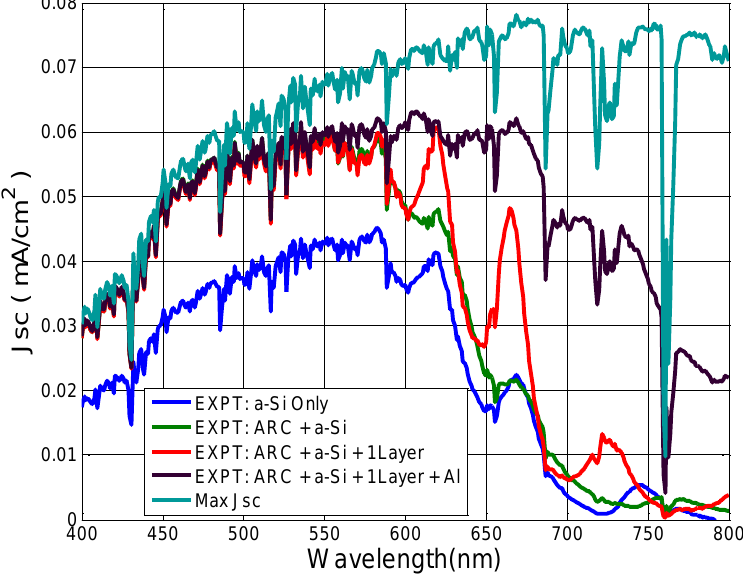
Figure 17. Plot of short circuit current characteristics ( J considered in this